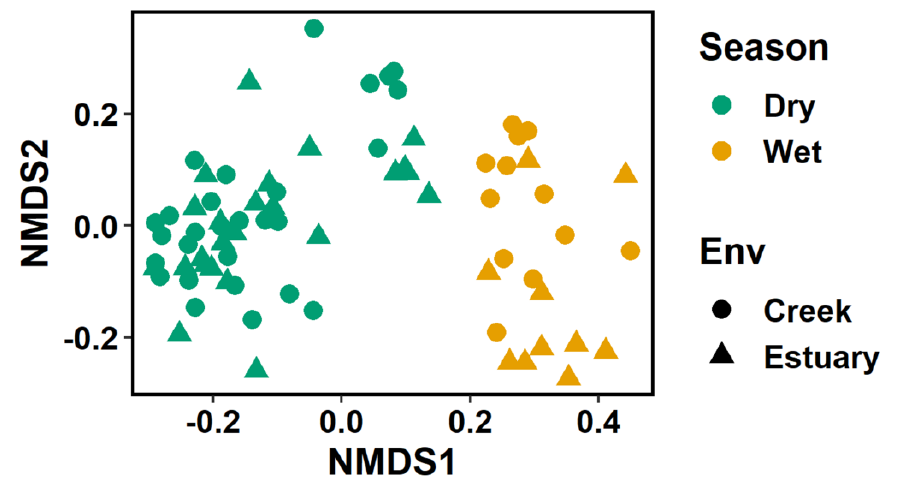
Figure 9. Non-metric multidimensional scaling (NMDS) test between sampling sites and seasons.